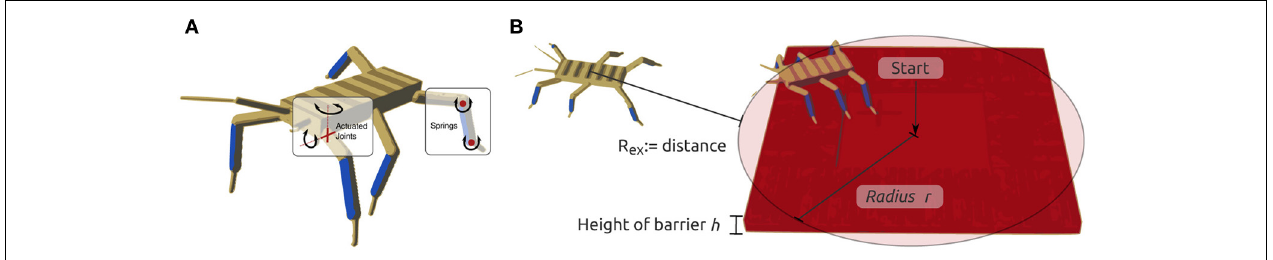
FIGURE 6 | Hexapod robot for self-rescue and the experimental setup. (A) The robot has 6 legs where the hind legs are 10% larger than the other legs. Each leg has two active DoF in the hip joint and one passive DoF in both the knee and the ankle joint